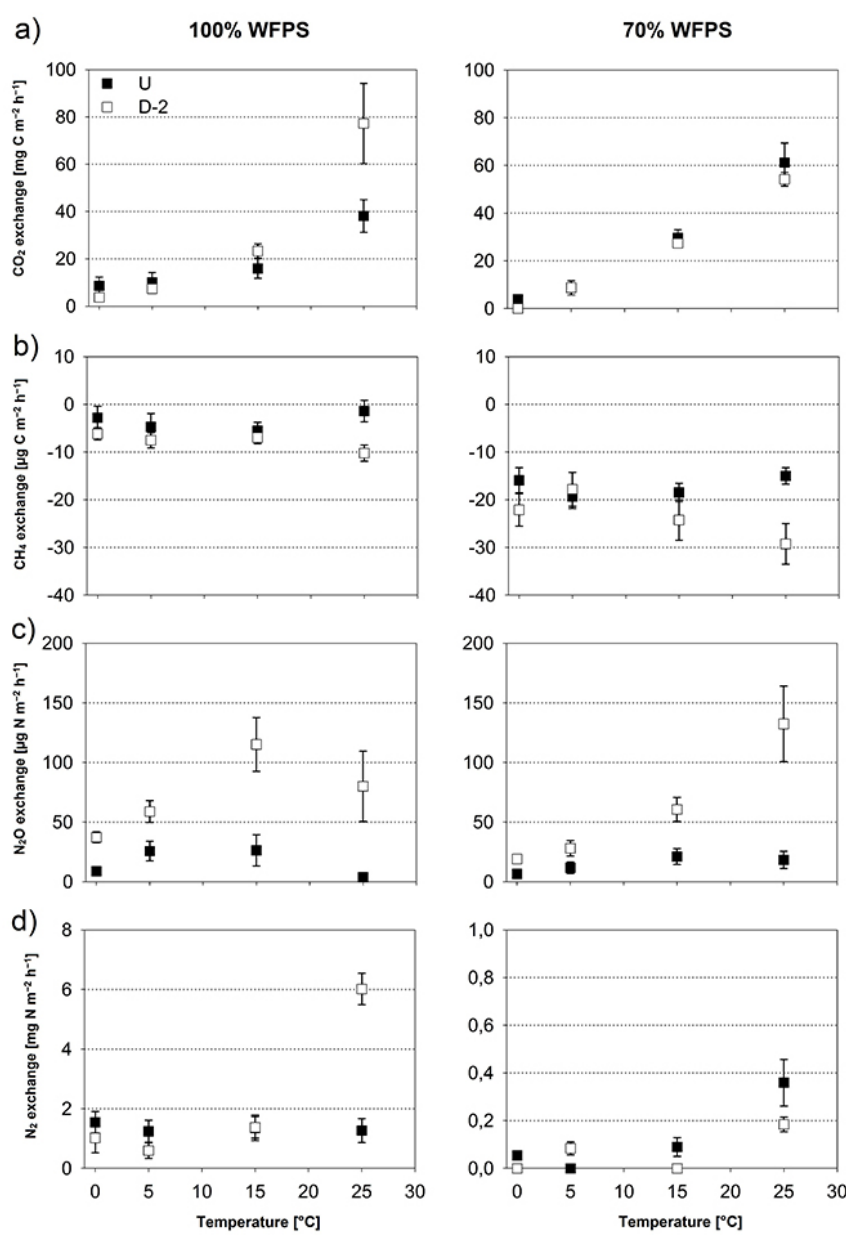
Figure 7. Mean ( ± SE, n = 5) of CO 2 (a) , CH 4 (b) , N 2 O (c) and N 2 (d) exchange rates per water-filled pore space (vol. %; 70% for D-2 and 83% for U), temperature ( ◦ C) and site treatment. U = undrained; D-2 = drained 2. Please note the different scales for the N 2 exchange